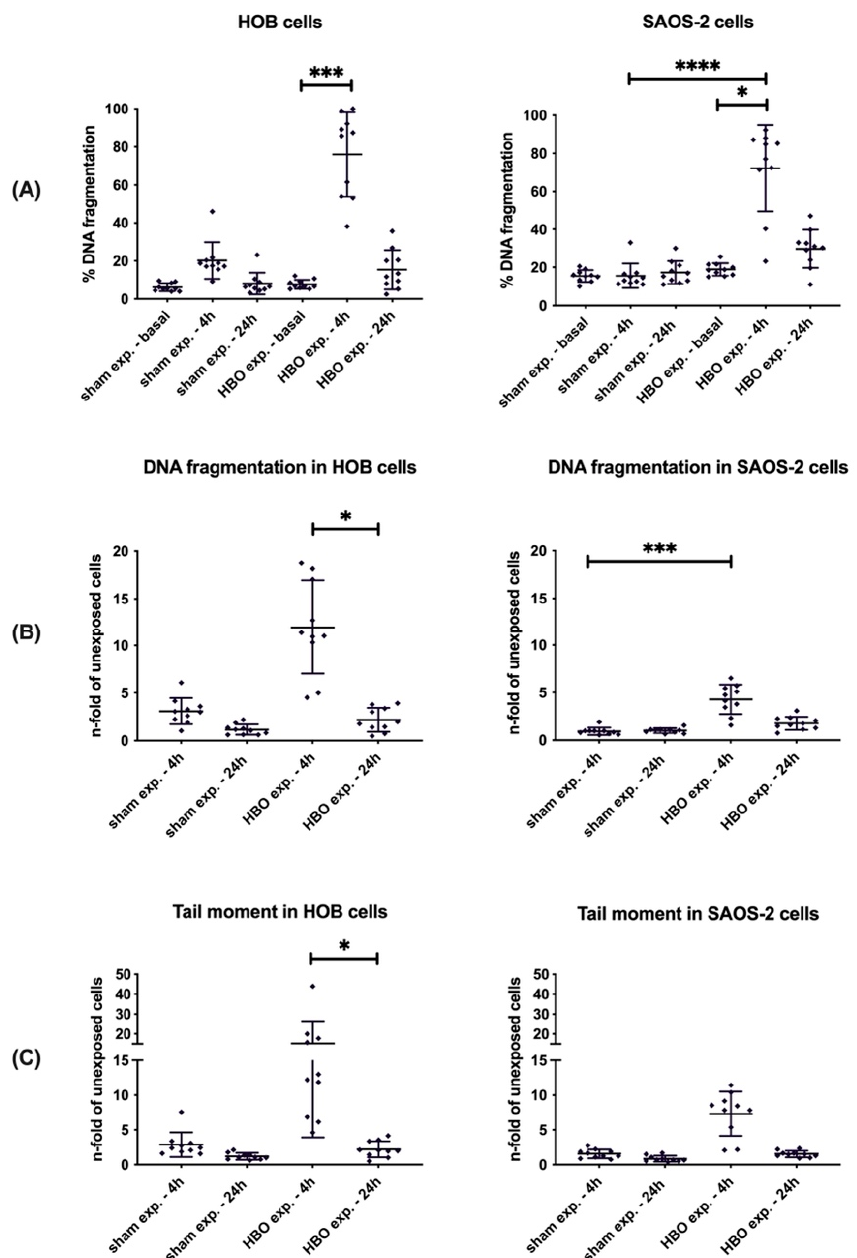
Figure 1. DNA fragmentation in human osteoblasts after exposure to hyperbaric oxygen (HBO exposure) and ambient air (sham exposure) analyzed with alkaline comet assay. ( A ) % DNA fragmentation in HOB and SAOS-2 cells; ( B ) DNA fragmentation in HOB and SAOS-2 cells after normalization to basal value; ( C ) DNA damage in HOB and SAOS-2 cells shown as tail moment after normalization to basal value. Data are presented as mean ± SD; p -values: * p < 0.05, *** p < 0.001, **** p < 0.0001.